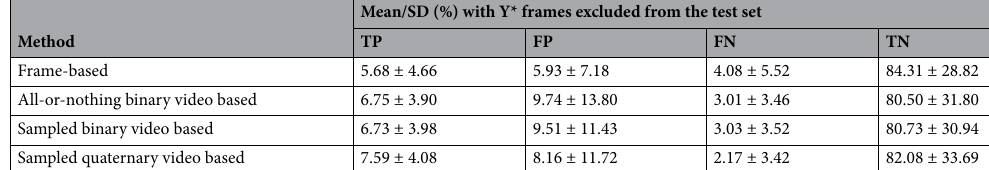
Table 7. The mean/std test-set confusion matrix for the 10-fold cross validation test-set results with videos labelled N (Section II.A2) excluded. Positives correspond to frames from LUS videos that contain signatures of consolidations (and associated imaging patterns) while negatives correspond to frames that do not. One of the 10 folds, which contained only healthy frames, was excluded from the results. Here Y* frames are frames Y* videos (Section